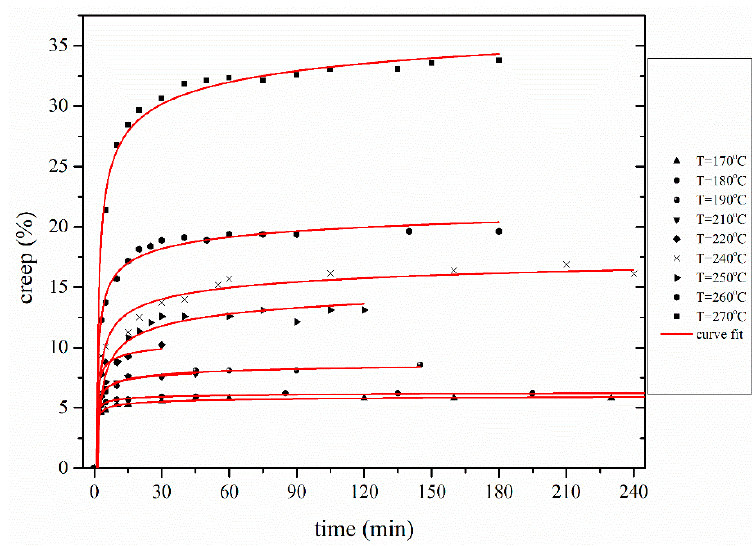
Figure 8. Creep elongation behavior during stabilization at isostress conditions at 12.87 MPa for YTD fiber.